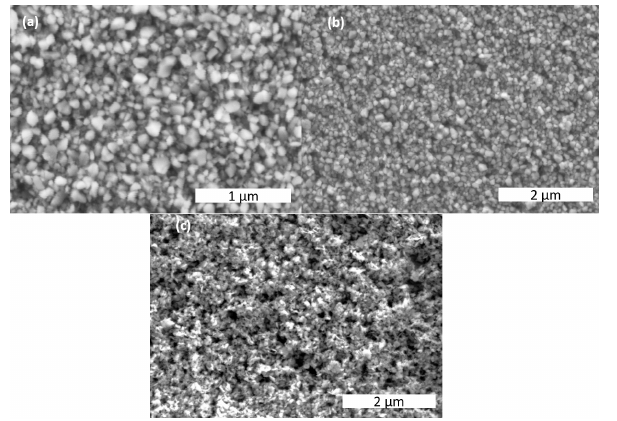
Figure 2. SEM images of (a, b) commercial Co 3 O 4 nano powder, after milling for 8h (c-Co 3 O 4 _8h) in different magnifications, and (c) synthesized Co 3 O 4 (s-Co 3 O 4